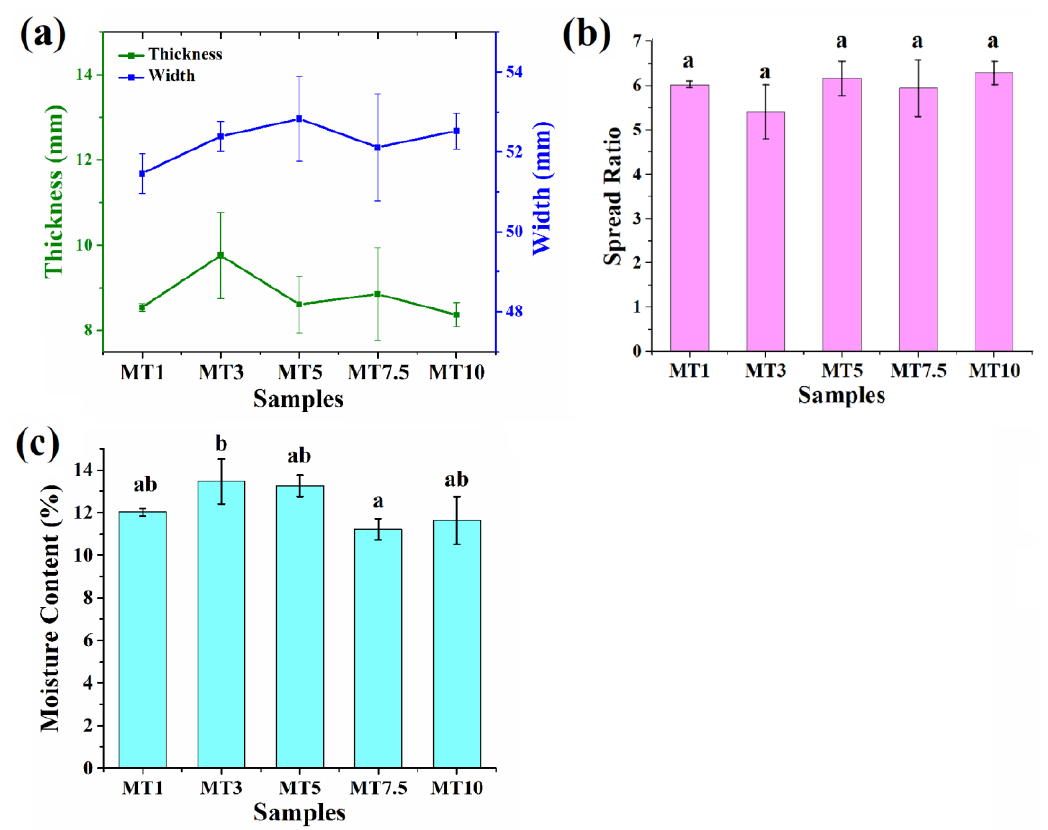
Figure 14. Parameters of cookie samples: ( a ) dimensions of the cookies, ( b ) spread ratio of the cookies, and ( c ) moisture content (%) of the cookies. Error bars represent the standard deviation of three replicates. For each chart, those not sharing the same letter(s) are significantly different by Tukey HSD test.